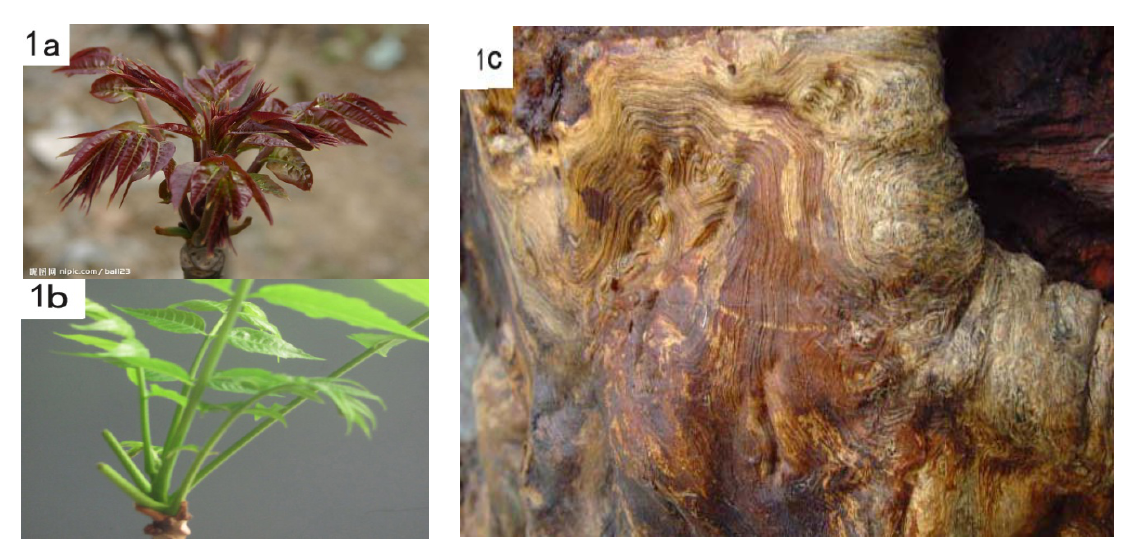
Figure 1. ( a ) Red young leaves of Toona sinensis ; ( b ) Green young leaves of Toona sinensis ; ( c ) Roots of Toona sinensis